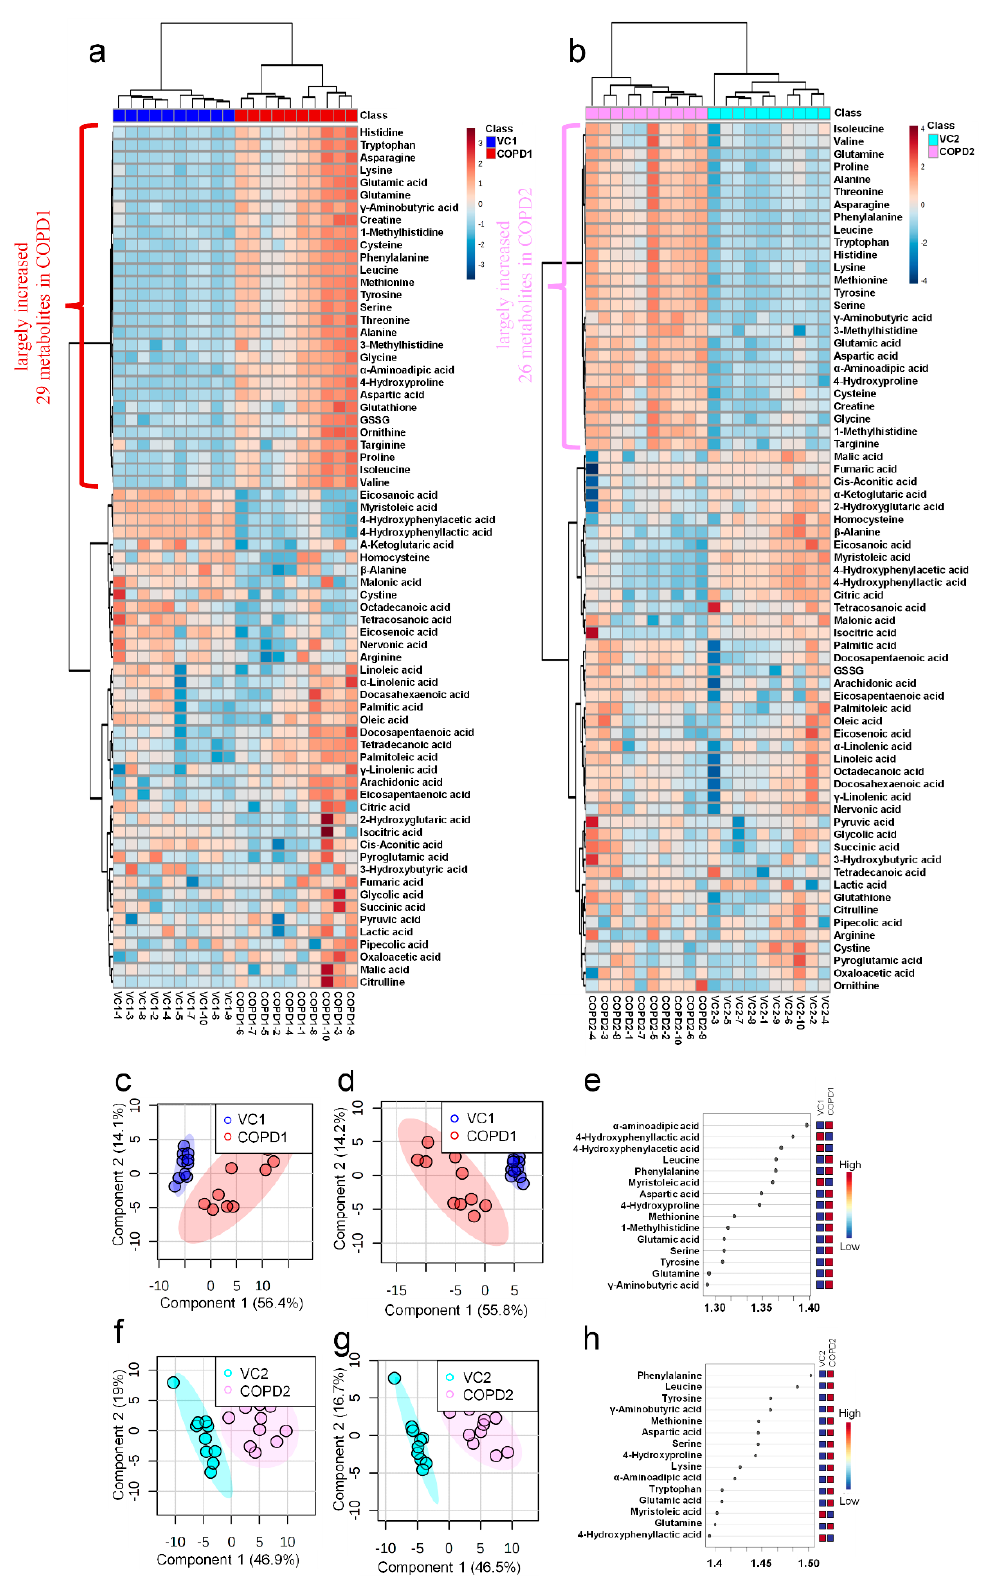
Figure 2. Hierarchical clustering heatmap ( a ), PCA scores plot ( c ), PLS-DA scores plot ( d ), and VIP score of top-15 metabolites in PLS-DA ( e ) of lung in COPD1 and VC1 groups. Hierarchical clustering heatmap ( b ), PCA scores plot ( f ), PLS-DA scores plot ( g ), and VIP score of top-15 metabolites in PLS-DA ( h ) of lung in COPD2 and VC2 groups.